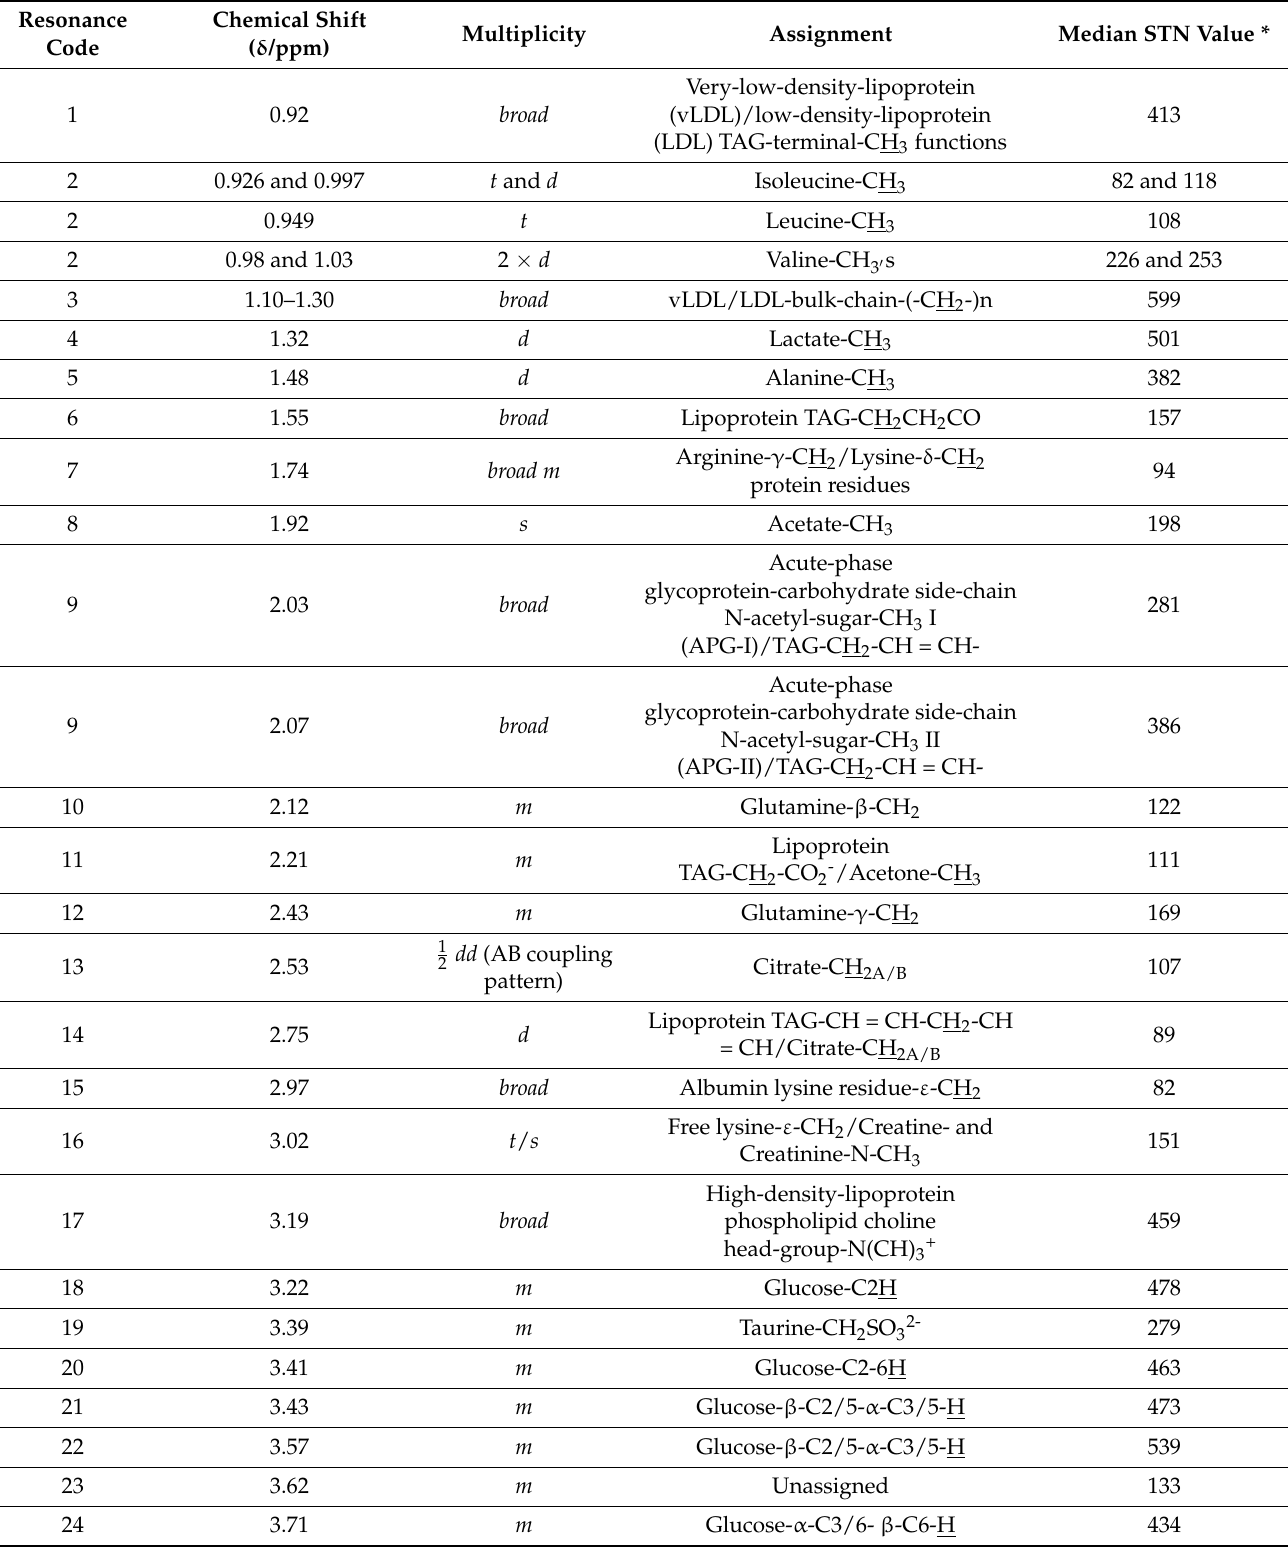
Table 1. Chemical shift values, multiplicities, and assignments for resonances present in the 1 H NMR profiles of blood plasma collected from GM1T2 and HC participants (Figure